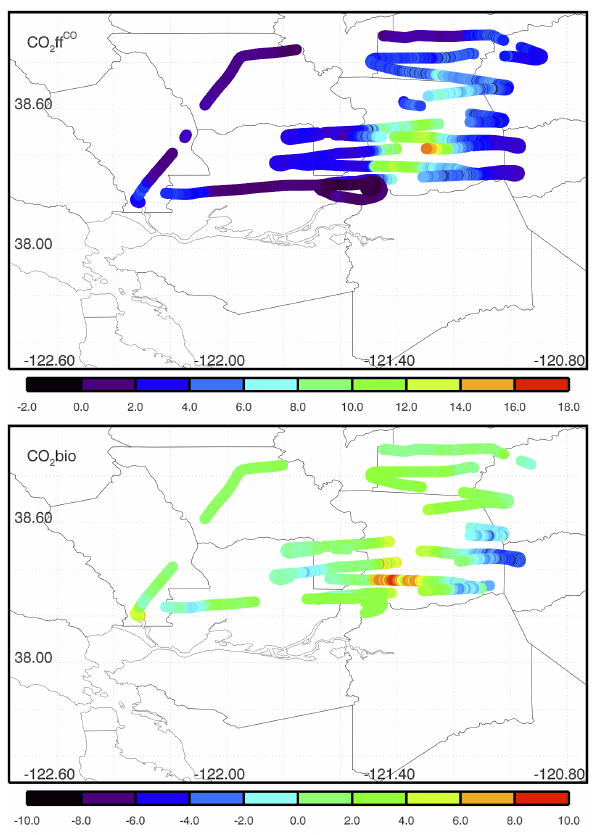
Fig. 8. Continuous CO 2 ff (top) and CO 2 bio (bottom) for SAC227 shown as a function of flight path. Units